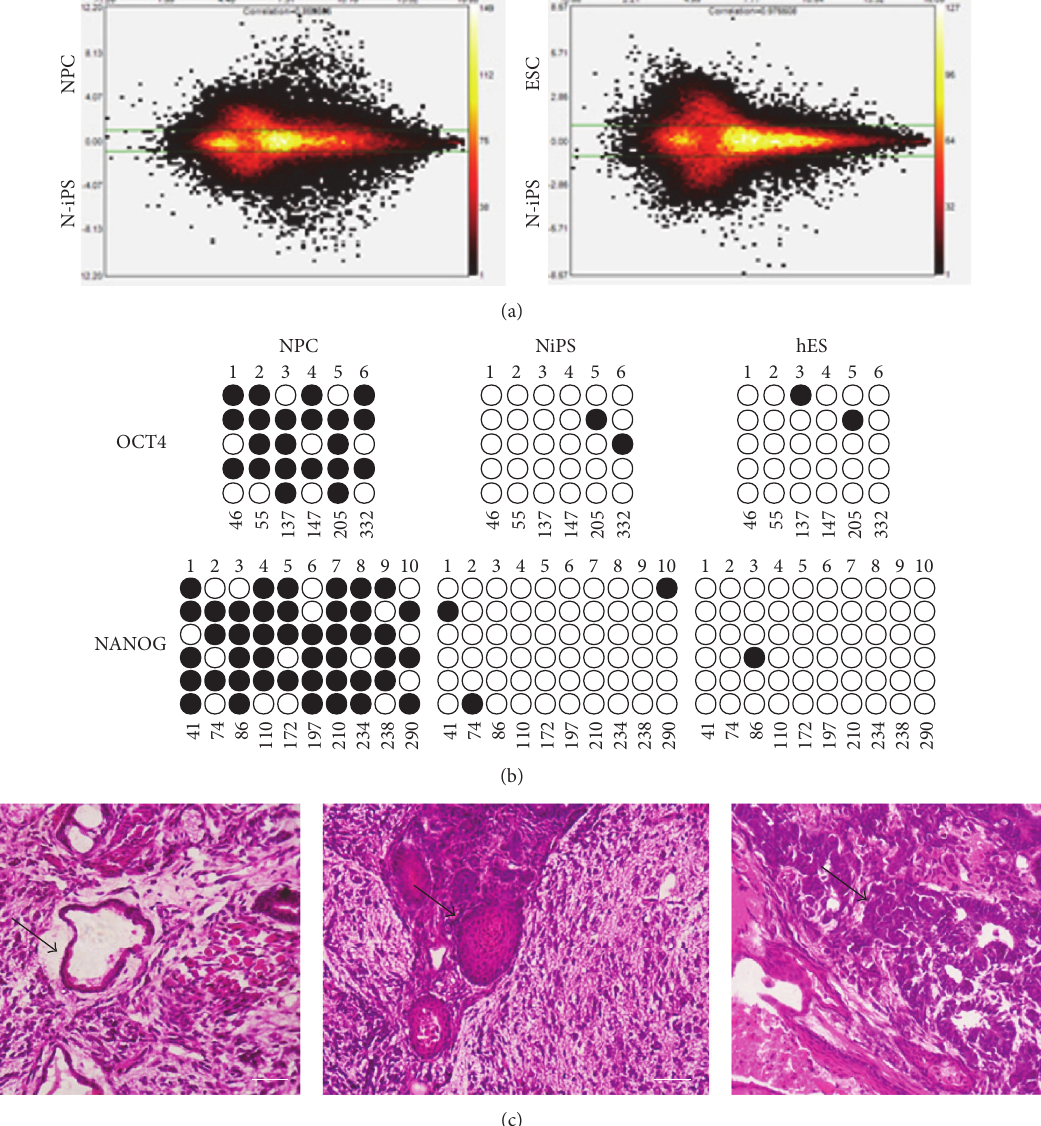
Figure 3: Analyses of DNA methylation and gene expression profiling in NiPS, NPC, and hES cells. (a) Analysis of gene expression profiling: the MvA plot is a comparison plot comparing two microarrays. The 𝑦 -axis is displayed on a log2 scale with green threshold lines for two-fold changes. The lower parts of MvA plot represent signals of NiPS cells, while the upper parts represent signals of NPC or hES cells. The color coding of the plot indicates the density of probes represented by that data point; (b) bisulphite sequencing analysis of OCT4 and NANOG promoter regions in human NSCs, 1F-OCT4 human NiPS clones, and human ES cells; (c) Hematoxylin and Eosin (HE) stain of teratomas generated from 1F-OCT4 derived iPS cells injected subcutaneously into immunocompromised SCID mice. Structures derivative of all three germ layers could be identified. (i) Neural tissue (ectoderm, left), (ii) cartilage (mesoderm, middle), and (iii) gut-like epithelium (endoderm,